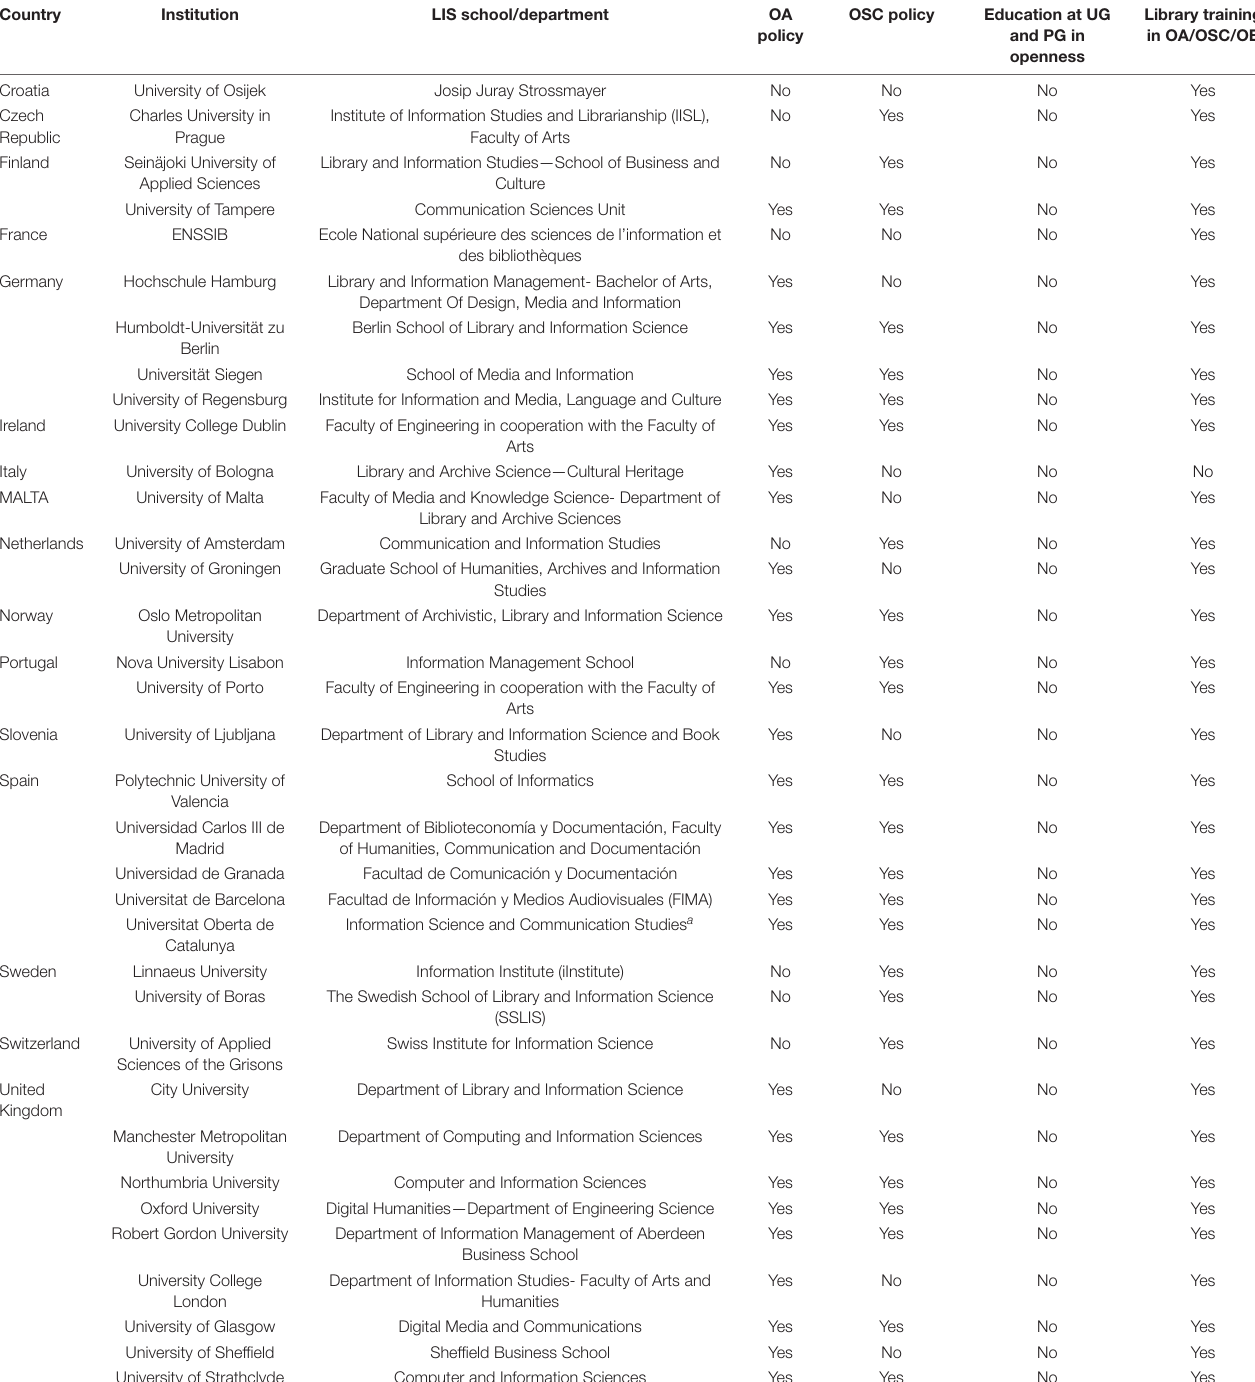
TABLE 4 | LIS schools: openness in curricula and capacity building in policies and library training.